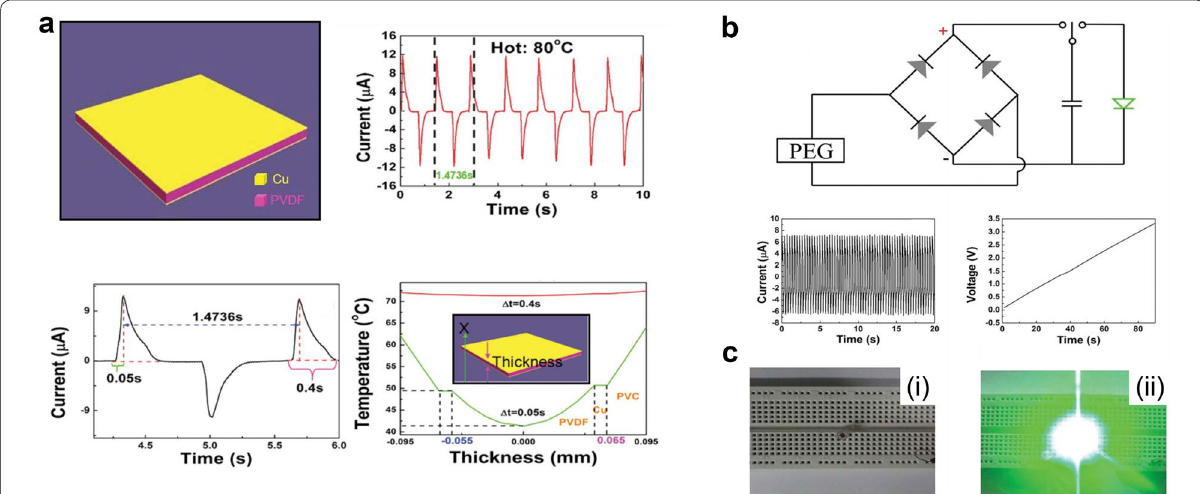
Fig. 7 a Schematic structure of P(VDF‑TrFE) based PNG and output current by contacting hot and cold water alternatively. b Equivalent circuit for charging system and capacitor charging behavior. c Switching on LED by PNG (Reproduced from [55] with copyright permission from 2014 Royal Society of